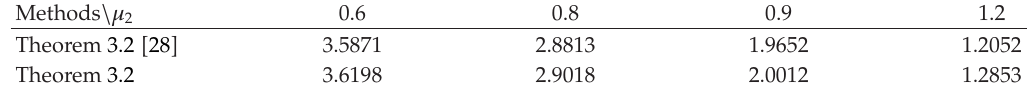
(cid:8) 1 and μ (cid:8) 0 . 5 in Example 4.1. max for l 1